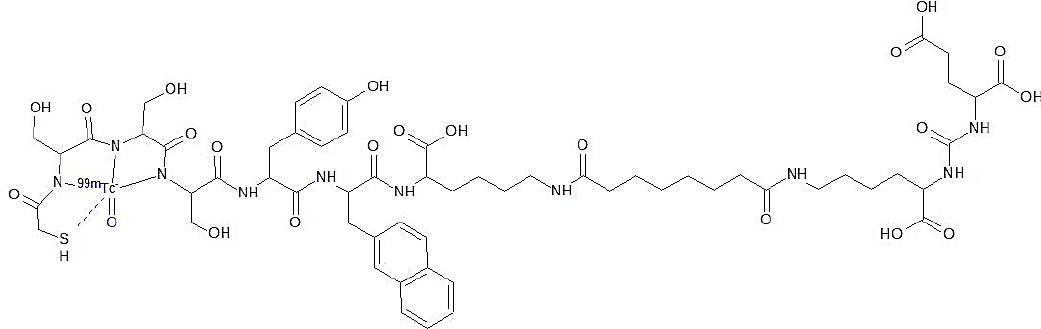
Figure 1. Chemical structure of [ 99m Tc]Tc-PSMA-I&S.